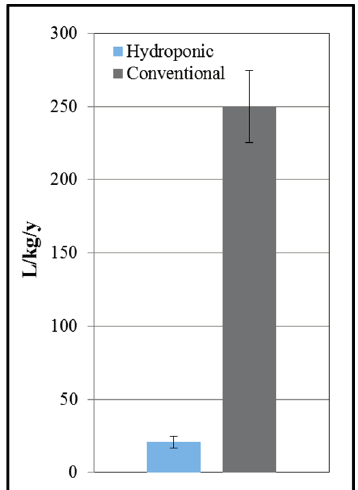
Figure 2. Modeled annual water use in liters per kilogram of lettuce grown in southwestern Arizona using hydroponic vs. conventional methods (Error bars indicate one standard deviation).